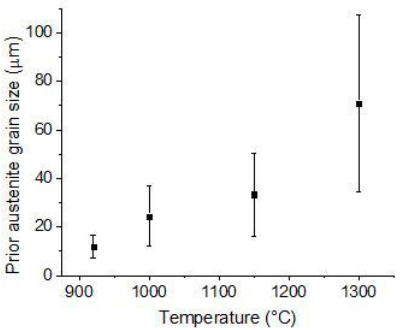
Figure 14. Prior austenite grain size (PAGS) as a function of austenitizing temperature.